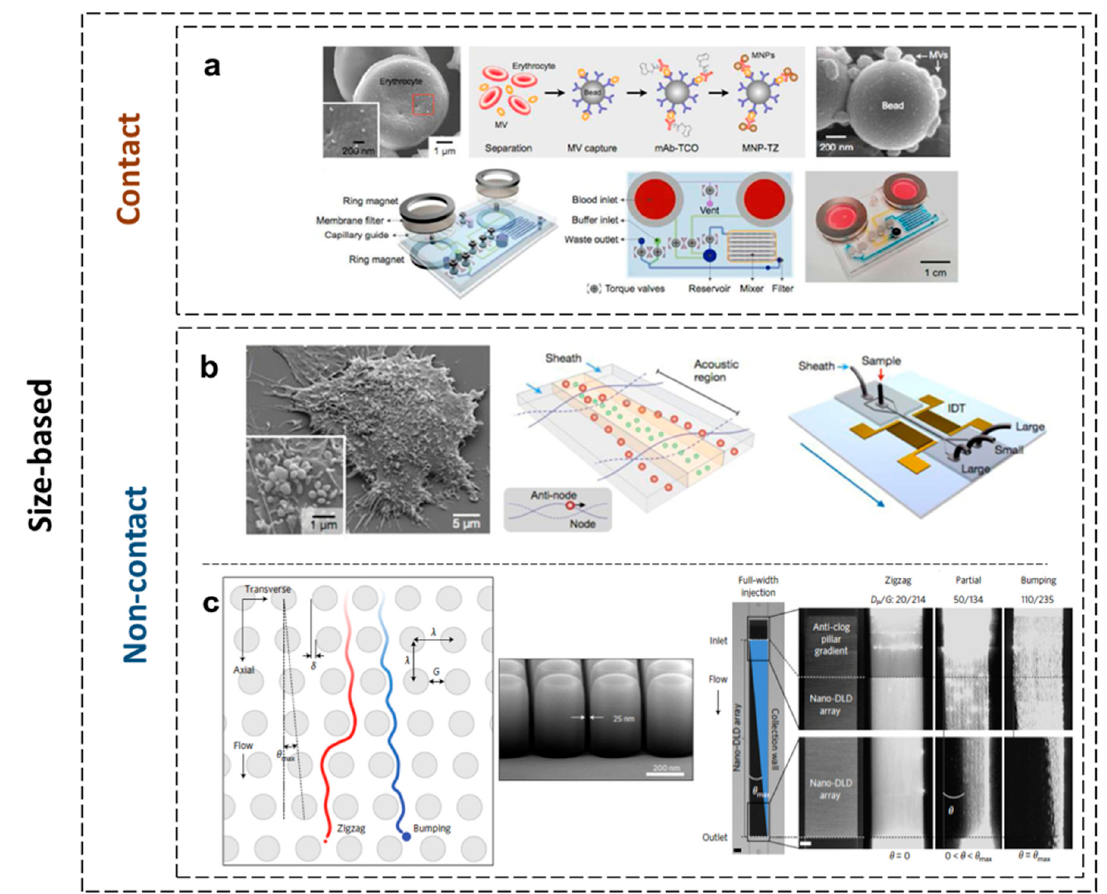
Figure 1. Size-based exosome separation techniques. ( a ) The nano-porous physical filtering technique. The microvesicles (MVs) are separated from blood and captured by antibody-coated microbeads with a mean diameter of 1 µ m. Immunomagnetic labeling subsequently renders the beads superparamagnetic [95] [reproduced with permission from [95], © 2013 American Chemical Society (ACS)]. ( b ) The non-contact acoustic nanofiltering technique where the MVs are moved in di ff erent locations of the microfluidic channels according to their acoustic response. Interdigitated transducer (IDT) electrodes shown in the schematic are used to generate surface acoustic waves across the flow direction [96] (reproduced with permission from [96], © 2015 ACS). ( c ) The nano-deterministic lateral displacement (nano-DLD) non-contact technique. Nanoparticle sorting accomplished using pillar array chips and the separation of polystyrene beads using a hydrodynamically focused jet in the nano-DLD array [97] (reproduced with permission from [97], © 2016 Nature publishing